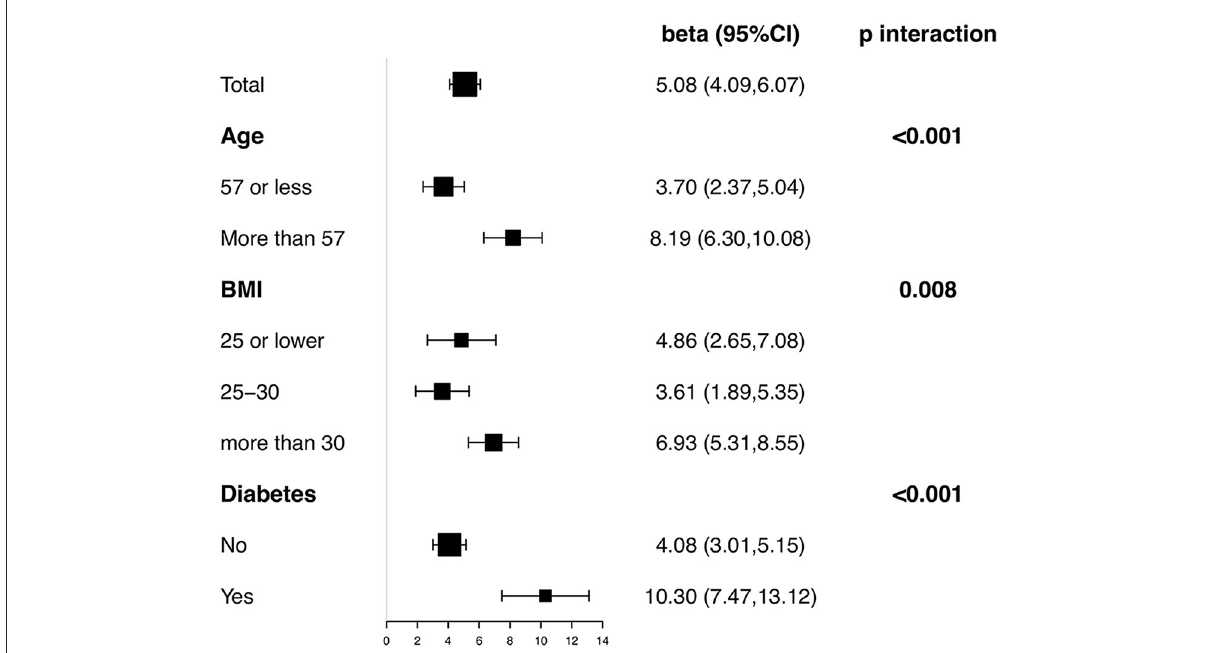
FIGURE4 subgroup analysis on association between serum soluble Klotho and